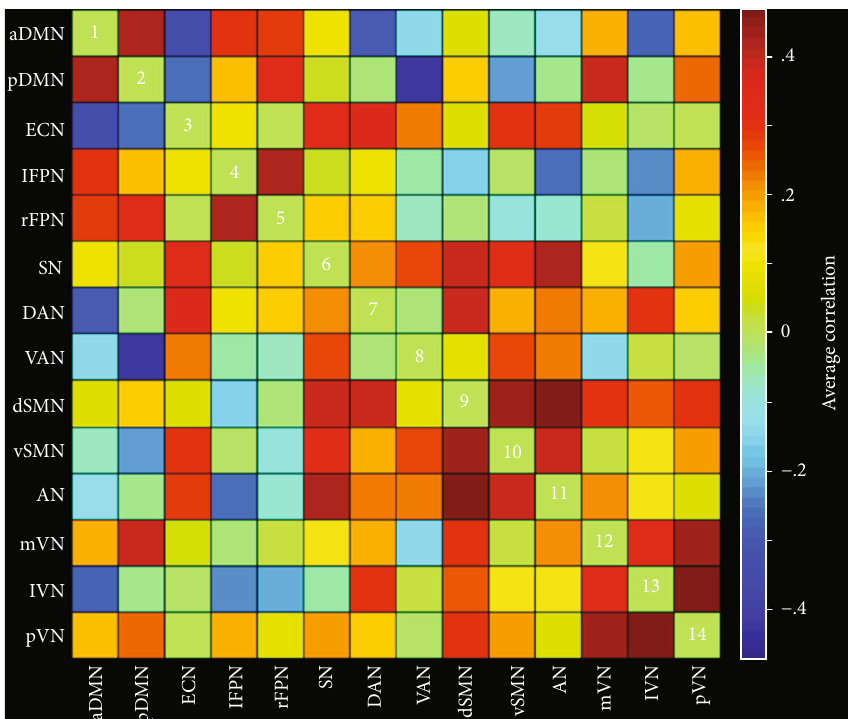
Figure 2: Internetwork functional connectivity matrix. Pairwise correlations between functional networks were averaged across subjects. Hot colors represent positive functional connectivity, and cool colors represent negative functional connectivity. Abbreviations: aDMN: anterior default mode network; pDMN: posterior default mode network; ECN: executive control network; lFPN: left frontoparietal network; rFPN: right frontoparietal network; SN: salience network; DAN: dorsal attention network; VAN: ventral attention network; dSMN: dorsal sensorimotor network; vSMN: ventral sensorimotor network; AN: auditory network; mVN: medial visual network; lVN: lateral visual network; pVN: posterior visual